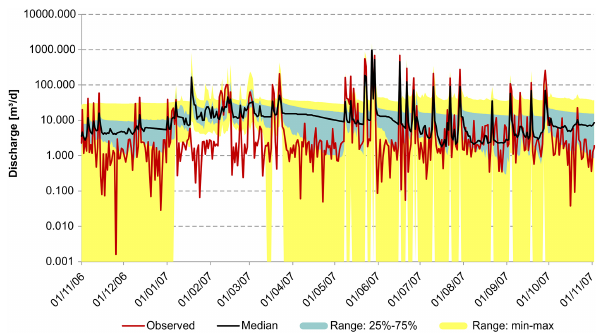
Figure 6. Discharge predicted for the hydrological year 2006/2007 (third